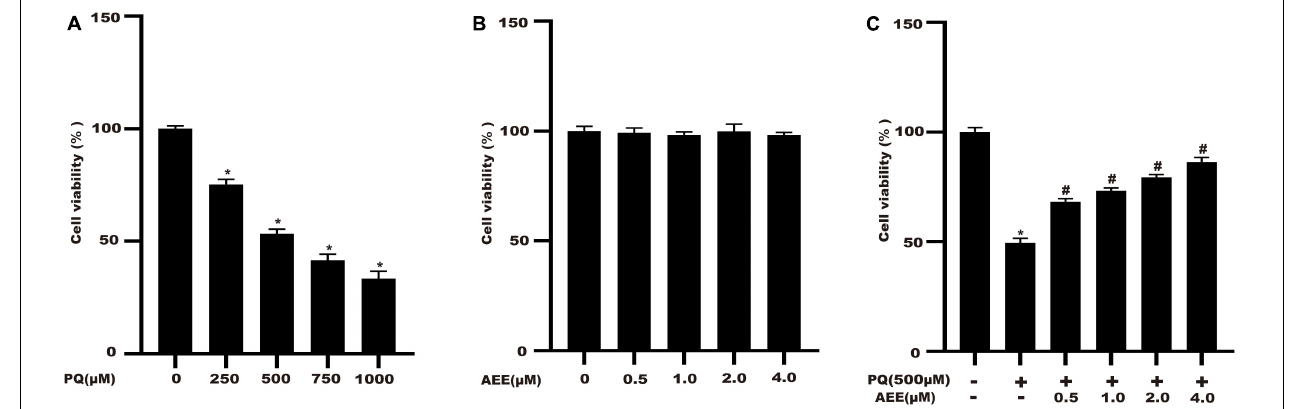
FIGURE 1 | AEE administration improves the cell viability of BRL-3A cells induced by PQ. Cell viability was measured by CCK-8. (A) The effect of different concentrations of PQ on cell viability after 24 h. (B) The effect of different concentrations of AEE on cell viability after 24 h. (C) The effect of pretreatment with different AEE concentrations on cell viability in the presence of 500 µ M PQ. Values are presented as the means ± SD where applicable ( n = 6). * p < 0.05 compared with the control group; # p < 0.05 compared with the PQ group.